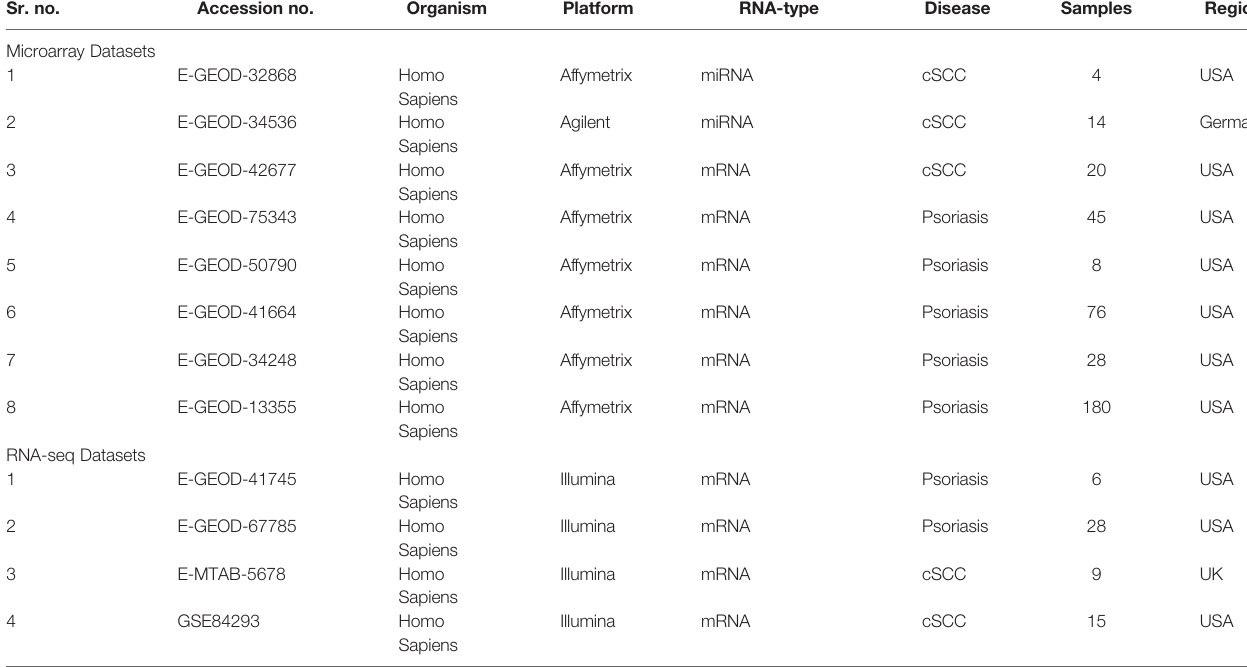
TABLE 1 | Microarray and RNA-seq datasets. Sr.